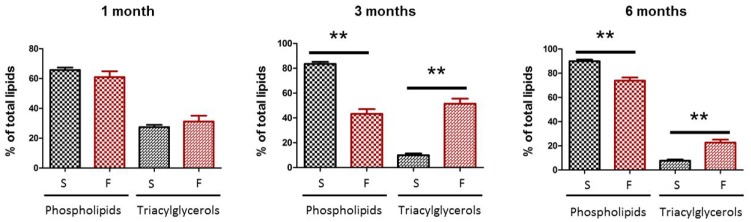
Liver steatosis is increased in rats fed with a 60%-rich fructose diet.Liver steatosis was evaluated by quantifying triacylglycerols (expressed in % of total lipids) in the liver of the rat after 1, 3, and 6 months of feeding with either the standard (S) or 60%-rich fructose (F) diet. ** statistically different at p≤0.01 (Mann & Whitney test). Values are given as means ± SD (n = 8 rats per group).